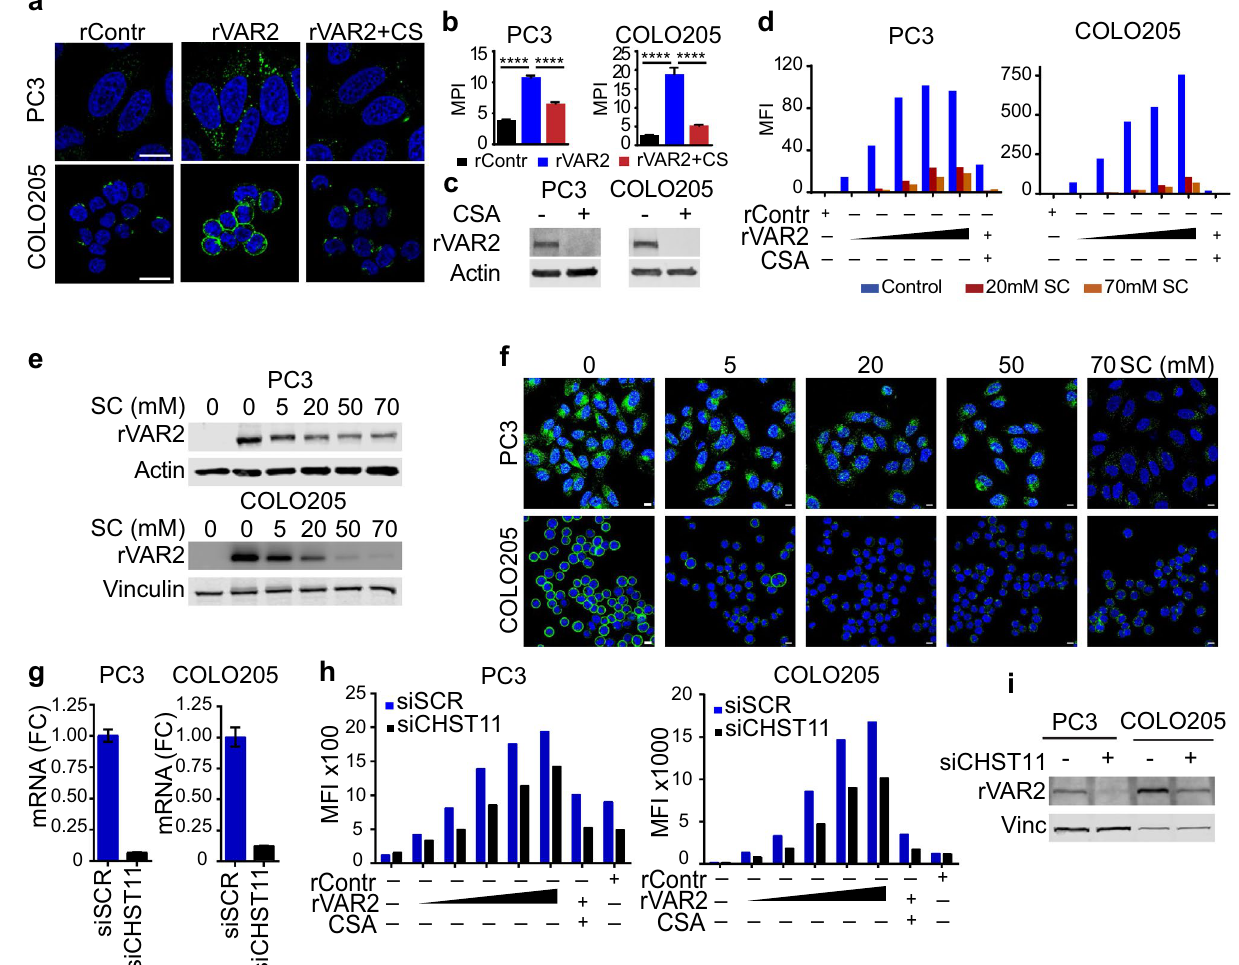
Figure 2. rVAR2 internalization depends on binding to cell surface CSA. ( a ) Immunofluorescence of rVAR2 in COLO205 and PC3 cells after 2 h incubation. (b) quantification for mean pixel intensity of AlexFluor488 signals in rContr, rVAR2, and rVAR2+ CS treated cells. Statistical analysis was performed on n ≥ 30 cells, ****p ≤ 0.0001 by ANOVA followed by Tukey’s post hoc analysis. Scale bar represents 10 µm. ( c ) Western blot for intracellular rVAR2 follow rVAR2 treatment in the presence or absence of CSA competition. ( d ) Flow cytometry analysis of rVAR2 binding in COLO205 and PC3 cells with and without SC treatment. ( e ) Western blot of internalized rVAR2 in COLO205 and PC3 cells after SC treatment at the indicated concentrations. rVAR2 was incubated for 1 h and vinculin was used as loading control. ( f ) Immunofluorescence images of rVAR2 after 1 h incubation in COLO205 and PC3 cells following SC treatment. Scale bar represents 10 µM. ( g ) CHST11 mRNA levels in PC3 and COLO205 cells as determined by qPCR and normalized to GAPDH. ( h ) rVAR2 binding analysis 48 h following control and CHST11 siRNA transfections in PC3 and COLO205 cells. ( i ) Western blot of internalized rVAR2 in PC3 and COLO205 cells following CHST11 knockdown, vinculin was used as loading